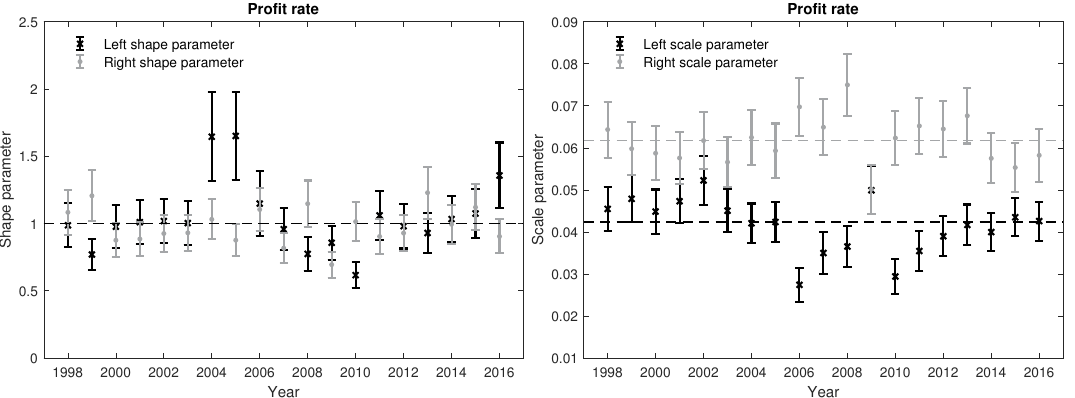
Figure 7. Estimates of the two shape parameters ( α l and α r ) and two scale parameters ( σ l and σ r ) for the profit rates distribution. The results refer to the 200 largest long-lived firms according to their sales in 2016. Gray and black dashed lines refer to the median of the estimates of σ l and σ r , respectively.